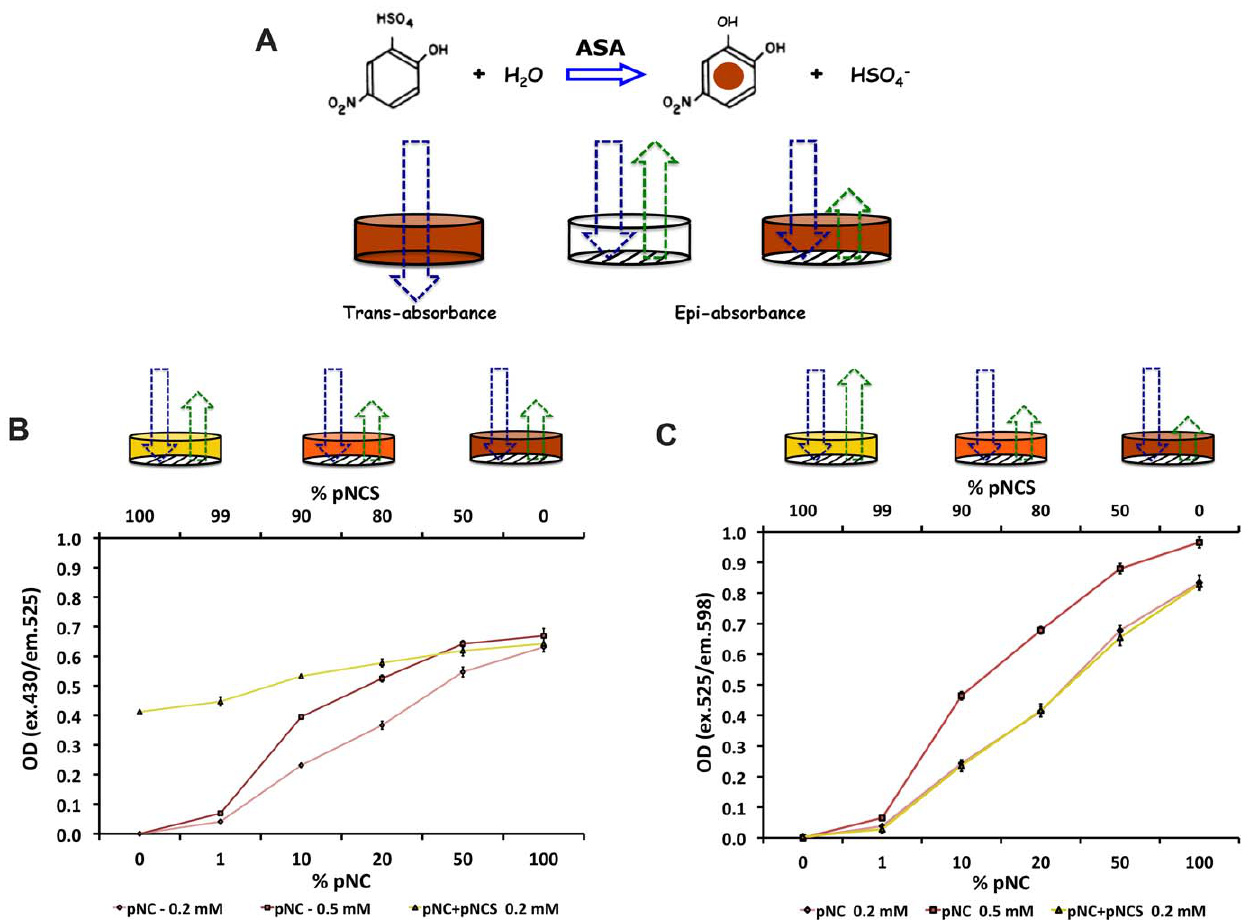
Figure 3. Development of a fluorescence-quench absorbance assay for ASA using a colorimetric substrate in white solid-bottom 1,536-well plates. ( A ) Basis of the fluorescence-quench absorbance assay. The desulfation of pNCS by ASA generates pNC, a colorimetric product, whose optimal absorbance is detectable at 515 nm. Thus, the reaction is performed in clear-bottom (transparent) microplates to measure trans- absorbance. Since white plastic solid-bottom plates have fluorescence properties [22], when an excitation light is directed to white solid-bottom microplates, emission light can be detected by epi-absorbance ( A ). The green arrow represents the fluorescence signal emitted from of solid-bottom of the well of a plate. Therefore, the generated pNC product can be used to quench the emission of the light from the bottom of each well in white solid-bottom plates. Based on this principle, the optimal concentrations of pNCS (yellow well) and pNC (brown well) were tested in white solid- bottom 1,536-well plates. Solutions with increasing %concentrations of 0.2 mM (pink lines) and 0,4 mM (red lines) of pNC were used. A pNC + pNCS mixed solution with decreasing %concentrations of 0.2 mM pNCS substrate and increasing %concentrations of 0.2 mM pNC product was used to simulate the effects of ASA over the pNCS substrate. ( B ) At excitation 430 nm and emission 525 nm (close to pNC absorbance, 515 nm), the pNCS substrate quenches fluorescence from the white solid-bottom plate showing an OD of , 0.4 at its initial concentration0.2 mM; yellow well with decreased green arrow). Consequently, a flat line with increasing of %concentrations of pNC product was generated (yellow line). (C) However, at excitation 525 nm (close of 515 nm) and emission 598 nm, pNCS no longer quenches the fluorescence from white solid-bottom plate (yellow well with increased green arrow), demonstrating an increasing OD signal with the increase of %pNC (product) and decreased %pNCS (substrate) in the mixed solution of pNCS + pNC. This pNC + pNCS solution (yellow line) overlaps with the solution containing only pNC at 0.2 mM (pink line). doi:10.1371/journal.pone.0029504.g003 plates. In order to test the robustness of the cell-based HTS assay, a pilot screening was performed utilizing the Library of Pharmacologically Active Compounds (LOPAC) containing 1,280 small molecules. The design and time-line of the HTS assay is depicted in figure 5. In the HTS assay, only SV40t cells from MLD patient (ASA-I179S) and control (ASA-WT) were used. In each 1,536-well plate, a control cell line (ASA-WT) was seeded in columns 2, 3, 46 and 47, as no pharmacological chaperone exists for ASA to be used as a positive control for the HTS assay. Columns 4 and 45 contain MLD patient cells only treated with DMSO. Columns 5 to 44 of these high-density plates is known as the ‘‘compound area’’, which includes 1,280 wells with cultured MLD (ASA-I179S) patient cells (Fig.5B). Thus, one 1,536-well